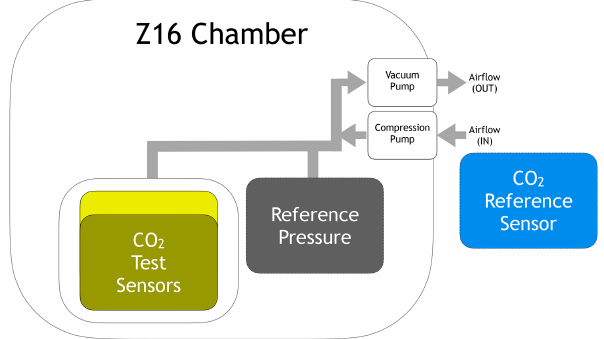
Figure 1. Diagram for the pressure chamber experiment. Two test sensors were placed inside the chamber, and a reference sensor was placed outside to indicate possible contamination and monitor the experimental